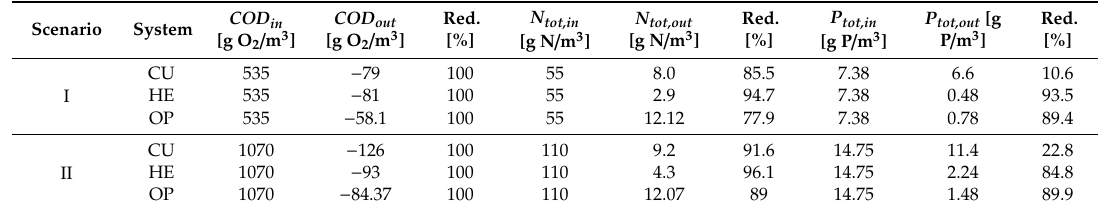
Table 1. Comparison of pollutant concentrations for polluted and purified